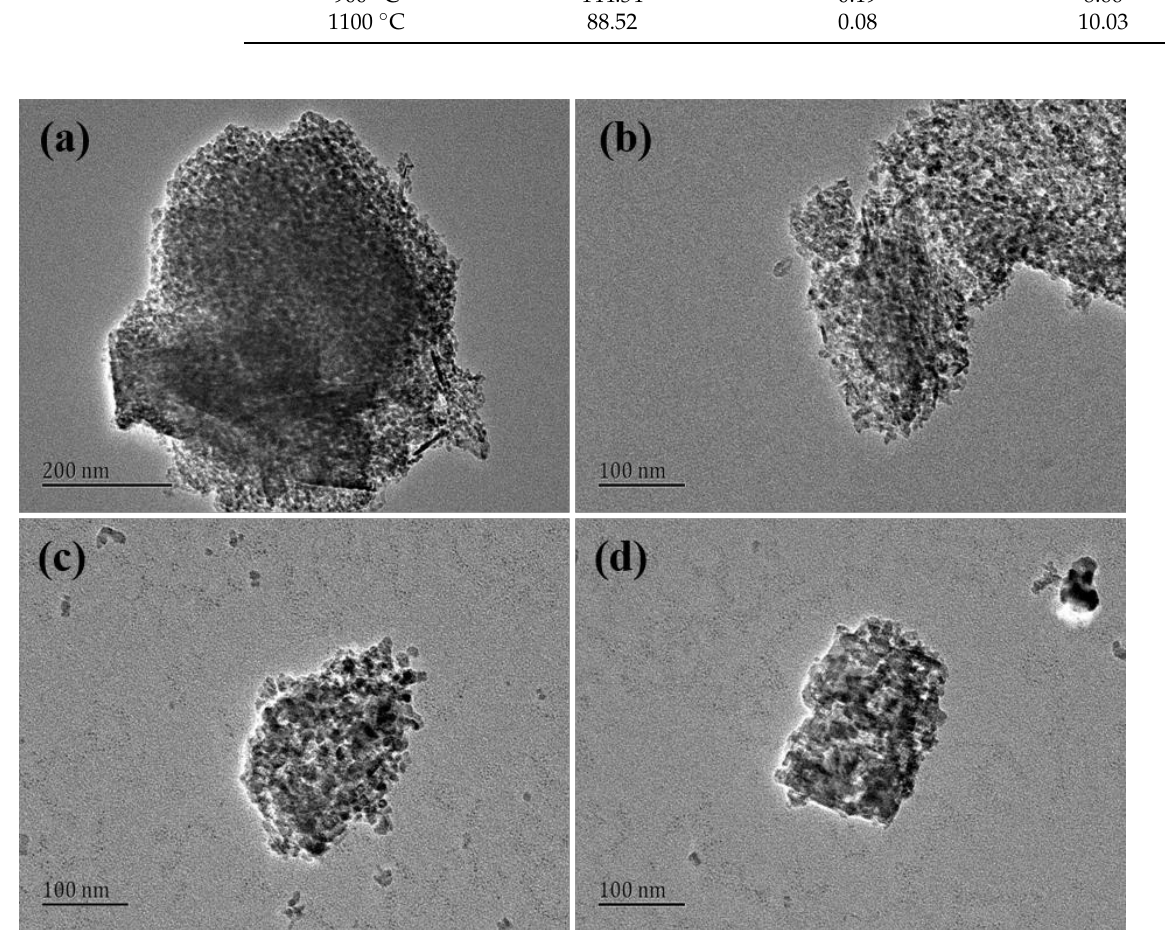
Figure 7. TEM images of HPMA materials obtained at different roasting temperatures: ( a ) 500 °C; ( b ) 700 °C; ( c ) 900 °C; ( d ) 1100 °C.